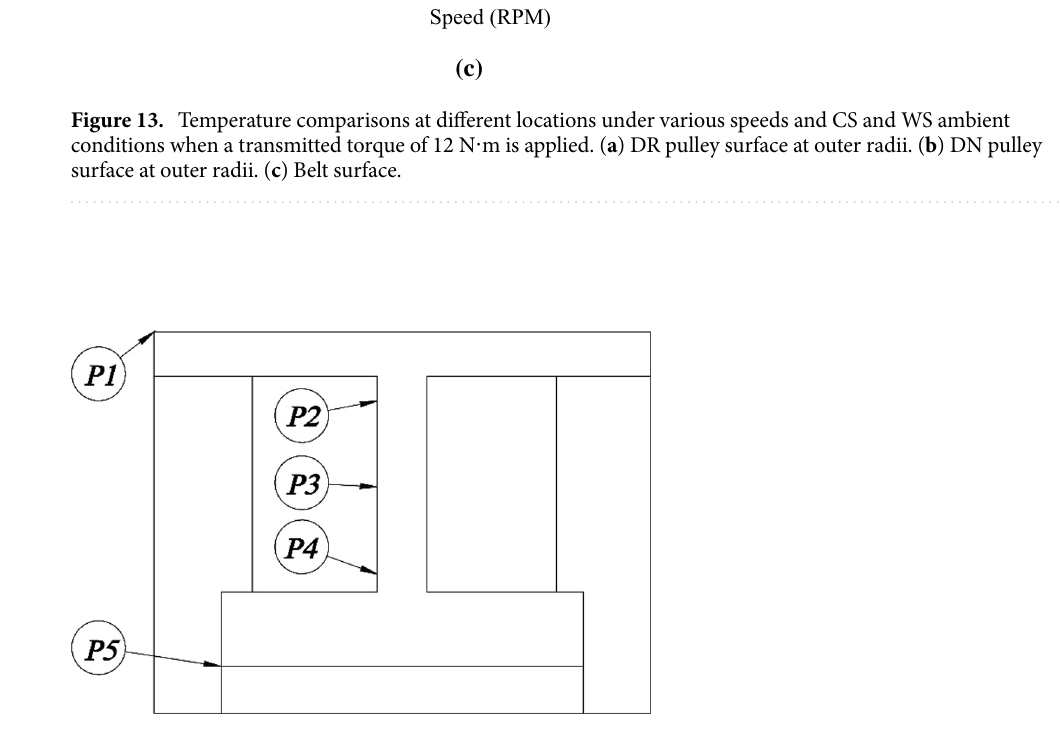
Figure 14. Selected points along the pulley